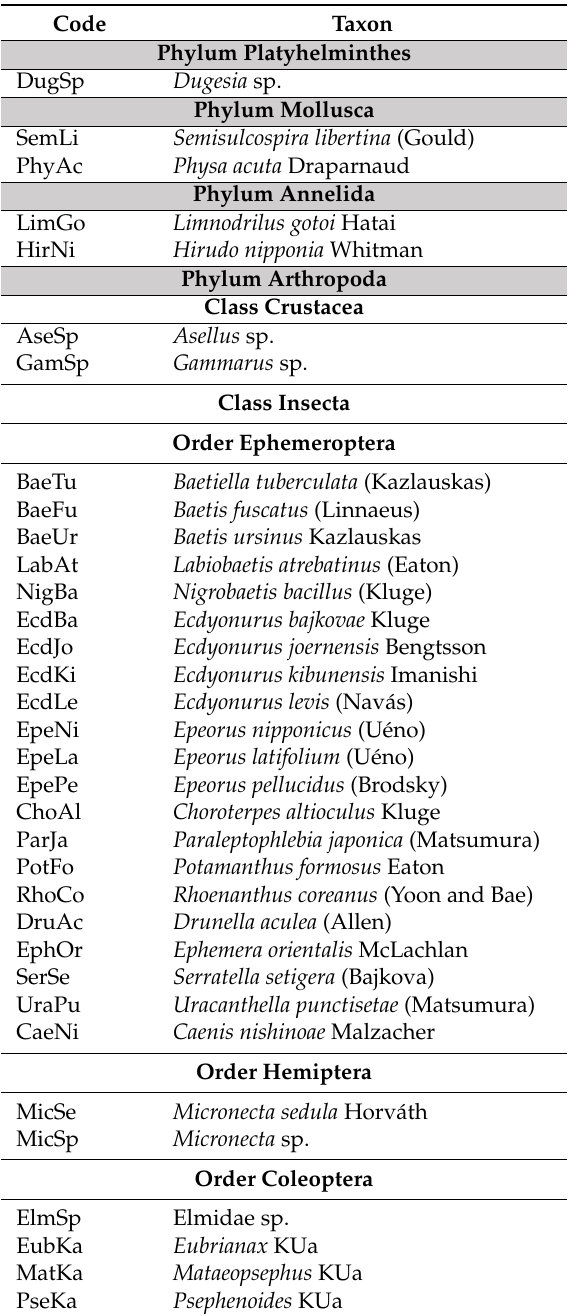
Table A1. Codes for macroinvertebrates contributing to more than 0.2% of total abundance for canonical correspondence analysis in Figure